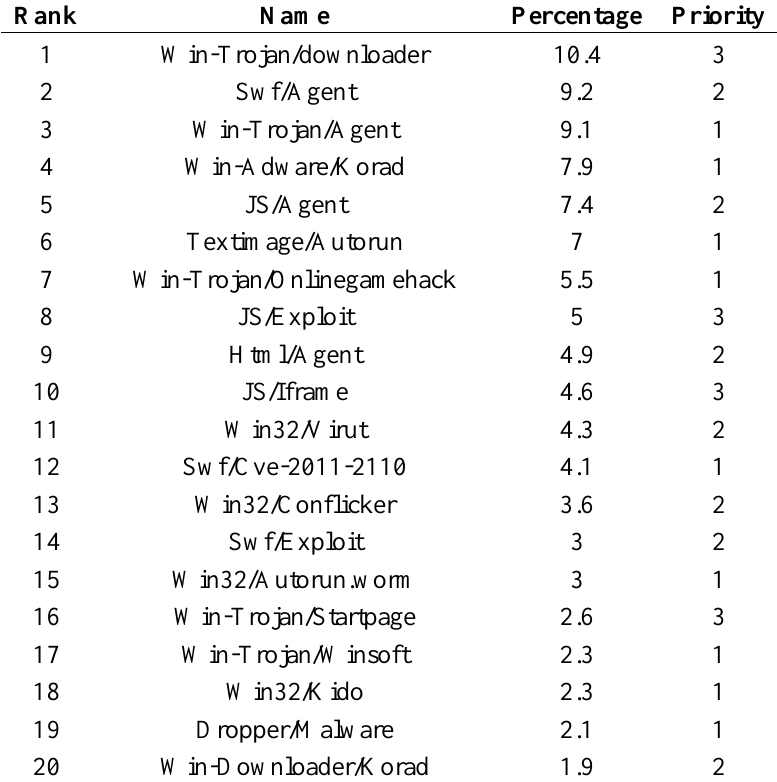
Table 2. Attack signatures, their occurrence, and priority from Ahnlab. Rank